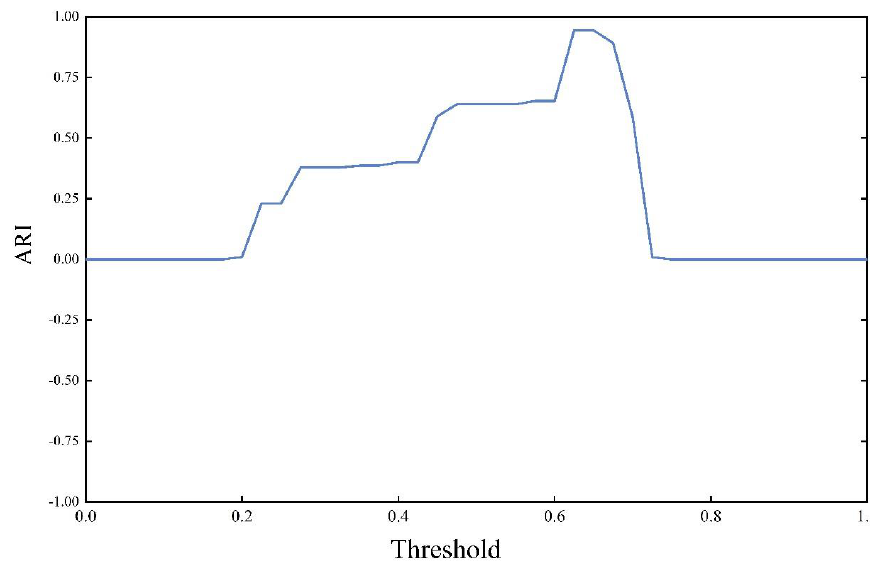
Figure 5. ARI values of the results predicted by the four models. Table 4. Time complexity and clustering accuracy of the four studied models. Models